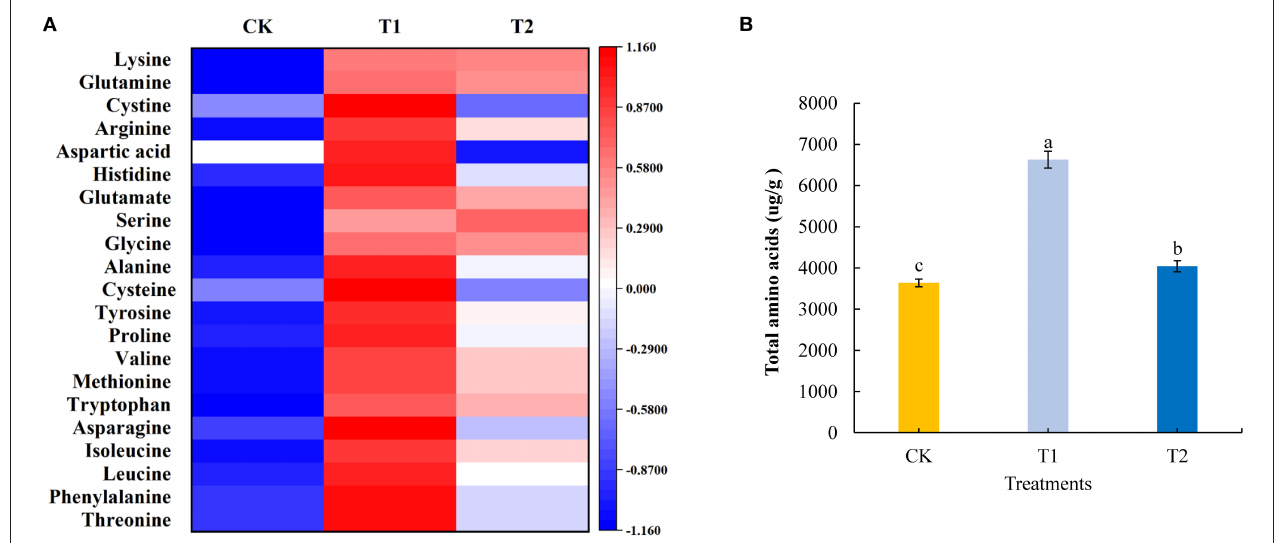
FIGURE 4 | Amino acid component (A) , total amino acids (B) contents in tomato fruits under different LED supplementary light periods. The data are expressed as average values ± SD ( n = 3). a − c Indicate significant differences between treatments ( P < 0.05, Duncan’s multiple range test). The bars indicate standard errors. CK, no light supplementation control; T1, light supplementation for 3h in the morning; T2, light supplementation for 3h in the